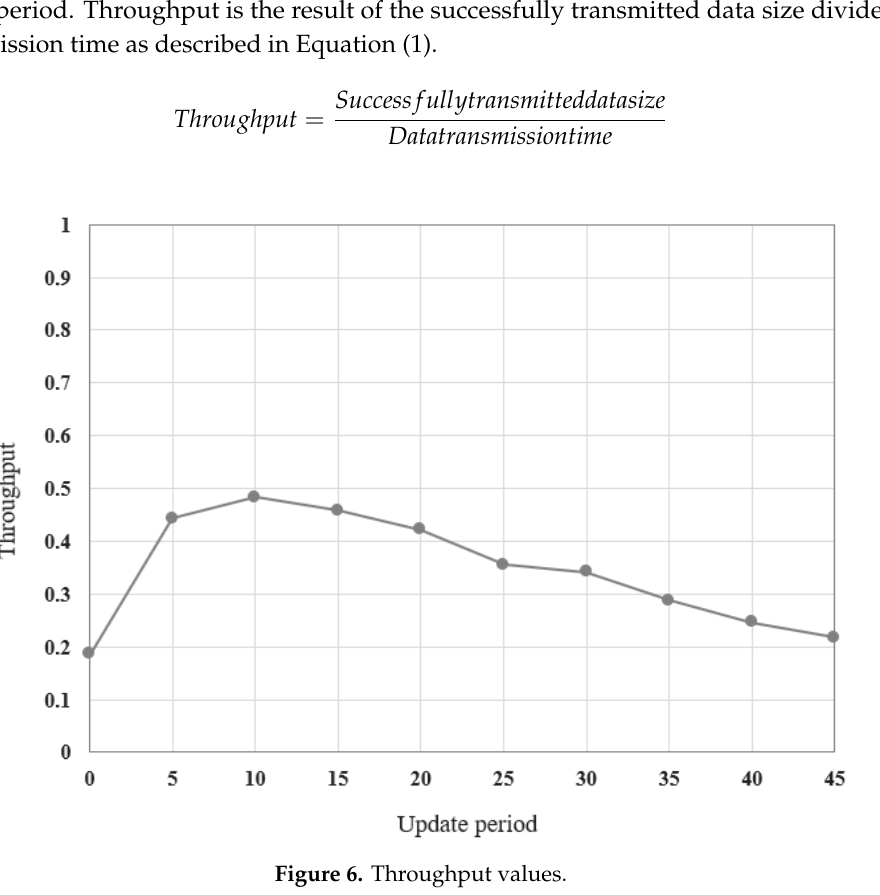
Table 3. Score increase criteria by each level according to the whitelist update period.